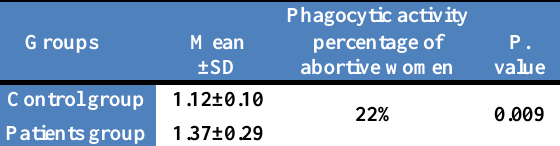
Table, 2: Nitro Blue Tetrazolium (NBT) index results of abortive women.